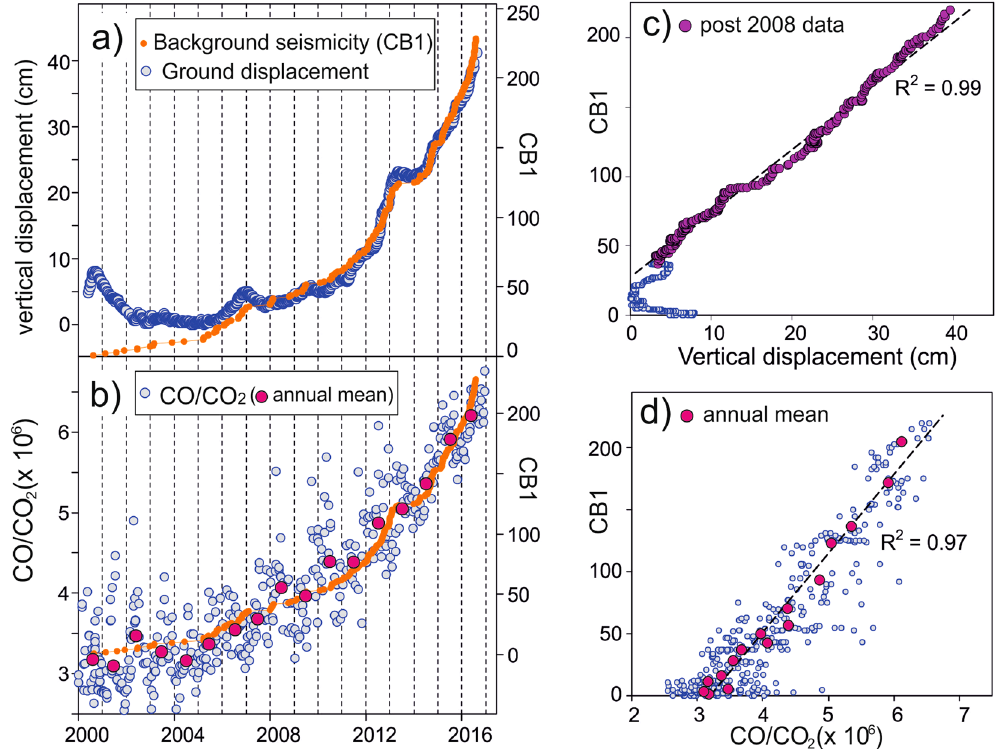
Figure 4. Background seismicity compared with other observations. ( a ) Chronogram of the cumulative background seismicity (orange dots, CB1) and vertical ground displacement at RITE CGPS station; ( b ) chronogram of the cumulative background seismicity (orange dots, CB1) and fumarolic CO/CO 2 ratios; ( c ) binary plot of the cumulative background seismicity (CB1) vs the vertical ground displacement at RITE CGPS station; ( d ) binary plot of the cumulative background seismicity (CB1) vs the fumarolic CO/CO 2 ratio (the magenta dots refer to annual mean values of both CO/CO 2 ratio and CB1).